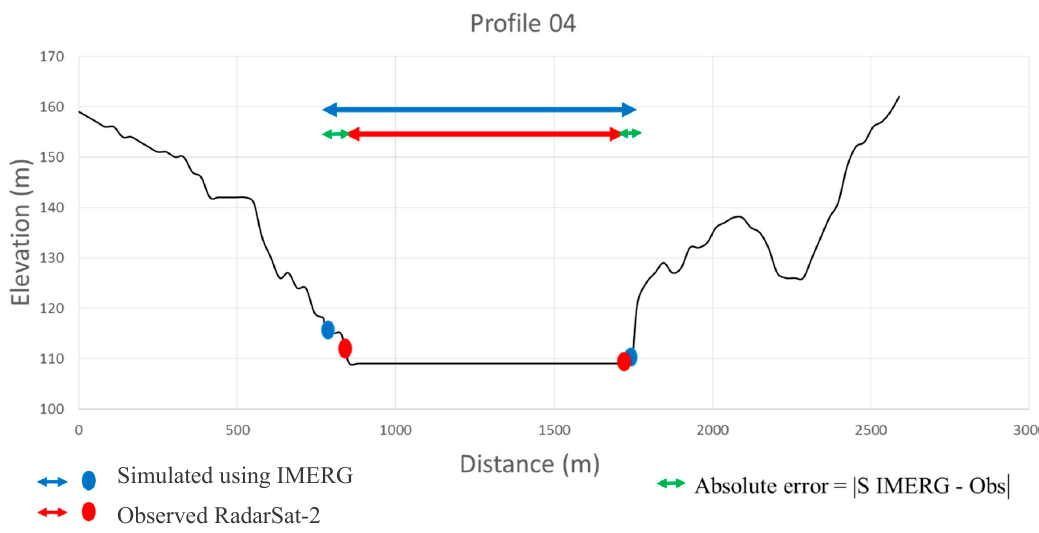
Figure 10. Accuracy assessment of the simulated flood map using topographical profile across the Ottawa River. S IMERG = simulated IMERG. For both sides of the riverbank, eight profiles out of ten show that the difference between the simulation map based on IMERG and the MILc model with simulation map based on observations from ground stations is equal to zero, except on the right side of Profile 3 and the left side of Profile 6. P Err values are reasonable (Table 4) considering that the pixel size of the 2D mesh used on the simulation is 90 m, except for the right side of Profile 3 and Profile 9. The use of discharge flood hydrographs based on IMERG and the MILc model for flood forecasting and mapping gives a satisfactory accuracy. 0.04 5. Conclusions It can be concluded from this paper that the estimation of discharge flood hydrographs based on IMERG products gives satisfactory accuracy. Consequently, flood forecasting based on IMERG products can play an important role in preparedness and mitigation of flood disaster management. The IMERG products might contribute to the use of space technologies more efficiently in flood risk reduction in emergency responses on global scale due to its large coverage. The use of forecasted flood discharge hydrographs based on IMERG and the MILc model gives encouraging results on flood extent mapping. These results were evaluated and compared with simulated flood extent maps based on observed discharge hydrographs by using ground stations. The difference between the two simulations is insignificant. The two simulations were evaluated, and